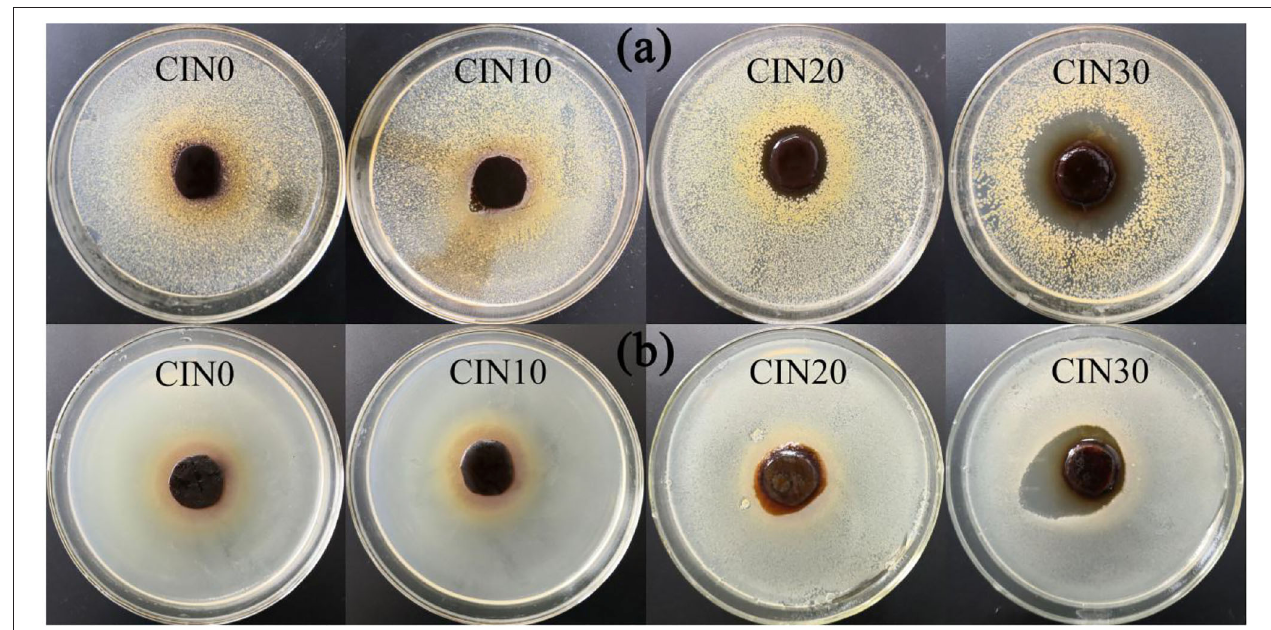
FIGURE 7 | The inhibition zones of GP-based composite films against (a) Staphylococcus aureus and (b) Escherichia coli